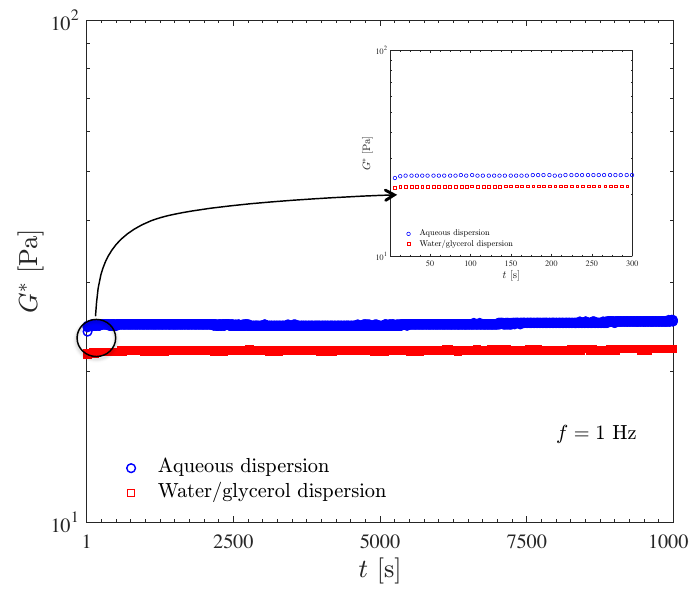
Figure 5. Evaluation of the stability of Carbopol dispersions by means of the time sweep test.